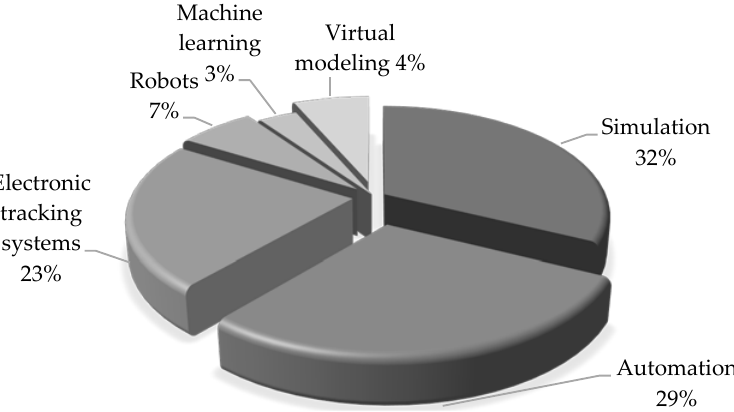
Figure 2. Main digital technologies used to support lean and Six Sigma interventions.